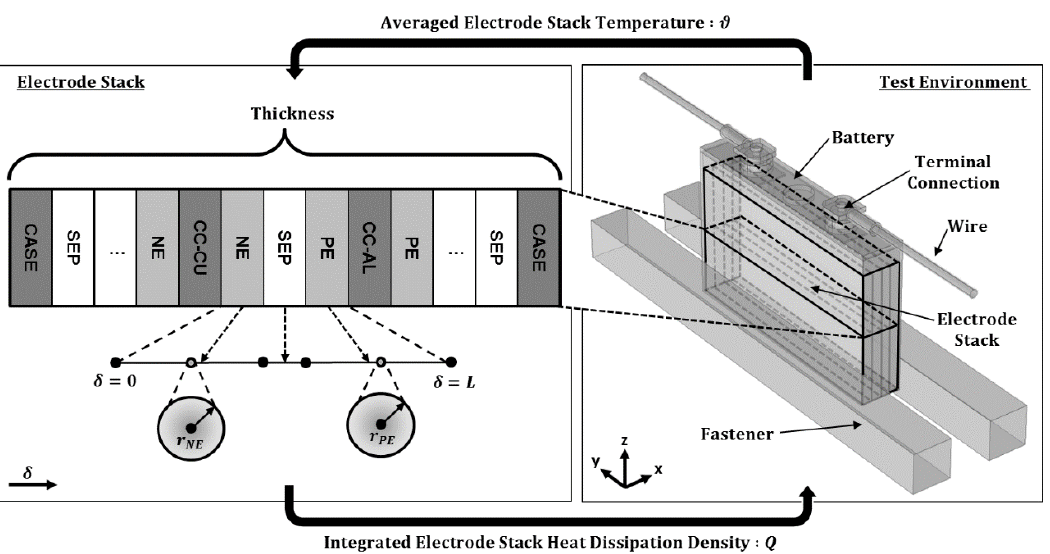
Figure 1. Schematics of the lithium–ion battery and heat transfer model.